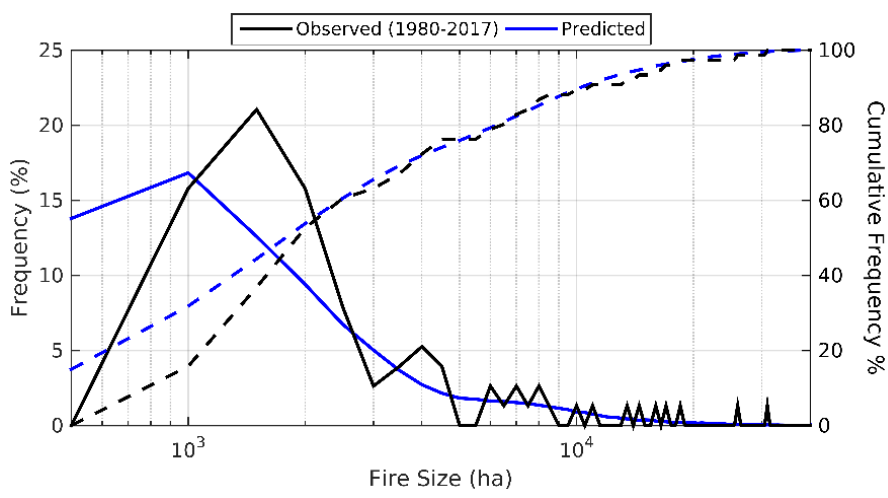
Figure 4. Comparison between observed and predicted fire size on a logarithmic scale. Filled lines represent frequency; dashed lines represent cumulative frequency (both in %).